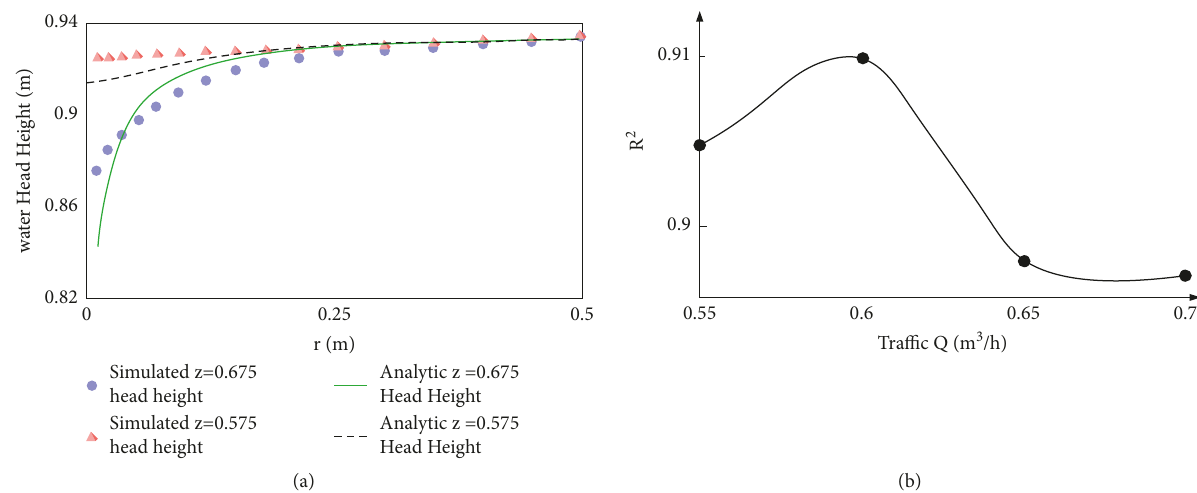
Figure 6: Numerical verification analysis of the model. (a) Comparison of the simulated and analytical solutions of the water head values at different depths of the reference model. (b) Flow rate Q vs. R